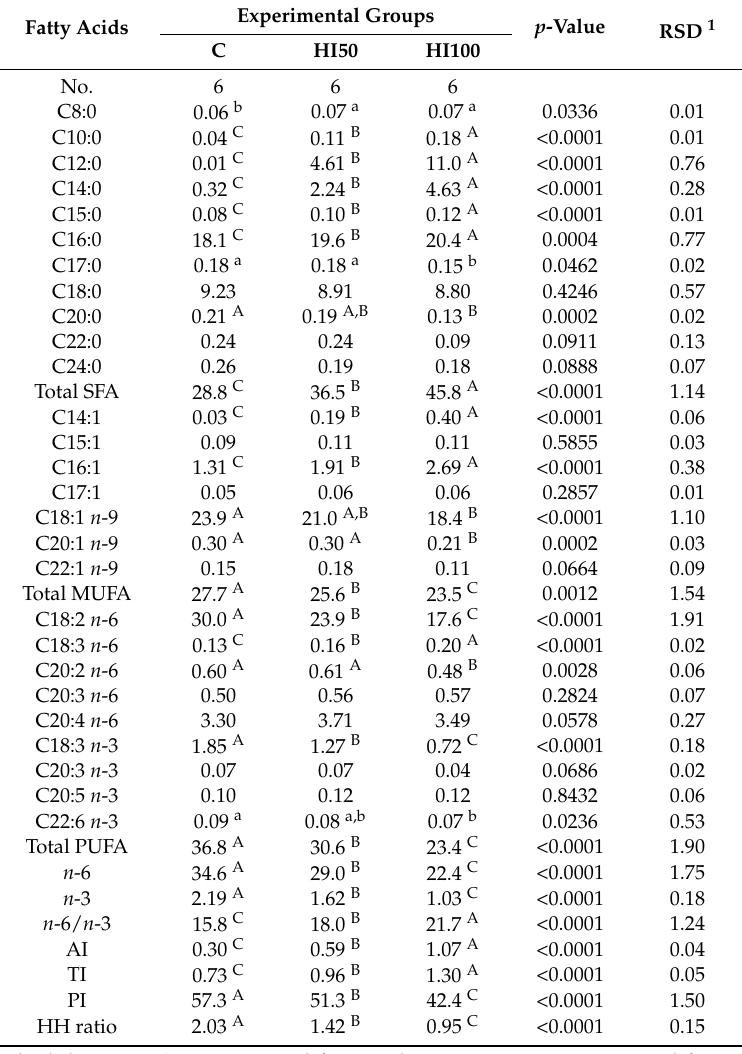
Table 5. Fatty acids profile (% of total fatty acid methyl esters; FAME) of the breast meat of chickens fed with 0% (C), 50% (HI50) and 100% (HI100) substitution of soybean oil with Hermetia illucens (HI) larvae fat in their finisher